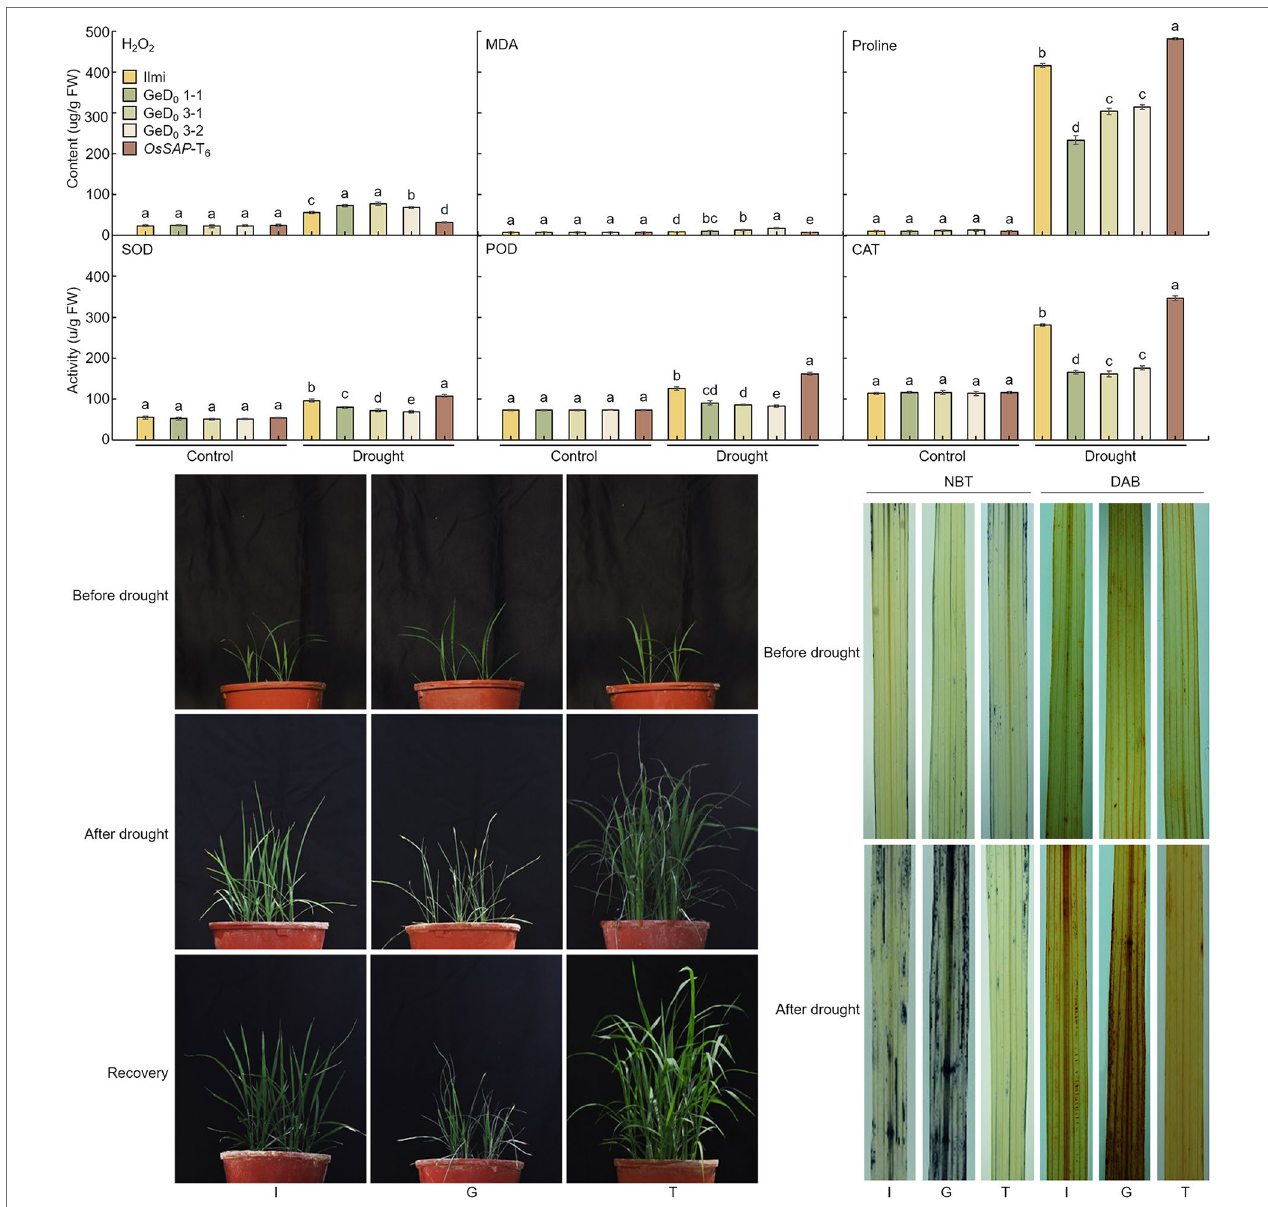
FIGURE 4 | Effects of OsSAP on cellular antioxidants and reactive oxygen species (ROS) levels in Ilmi, GeD, and OsSAP -T 6 lines under normal and drought conditions. Under drought conditions, the effects of OsSAP on the level of endogenous hydrogen peroxide (H 2 O 2 ), the accumulation of malondialdehyde (MDA), the accumulation of proline (proline), the activity of superoxide dismutase (SOD), the activity of peroxidase (POD), and the activity of catalase (CAT). Data presented are expressed as mean ± SD from five independent biological experiments per line. Bars represent means ± SE. Means denoted by the same letter are not significantly different ( p < 0.05) as evaluated by Duncan’s multiple range test. The GeD lines showed reduced drought tolerance, whereas the OsSAP -T 6 lines showed increased drought tolerance before drought stress, and 20 days after germination. Drought stress treatment; phenotypic changes at 20% soil moisture content. Phenotypes after 7 days of recovery achieved by watering (recovery from 20% soil moisture content). Phenotypes of 3,3-diaminobenzidine (DAB) and nitro blue tetrazolium (NBT) staining when the soil moisture content was 20%. After drought stress treatment, H 2 O 2 was visualized as brown spots by DAB, and O 2 − as blue spots by NBT. The picture presented is the most representative of five independent biological experiments per each line. I: Ilmi. G: GeD 0 1–1. T: OsSAP -T 6 . Different letters on columns represent significant ( p < 0.05) difference between rice lines based on Duncan’s